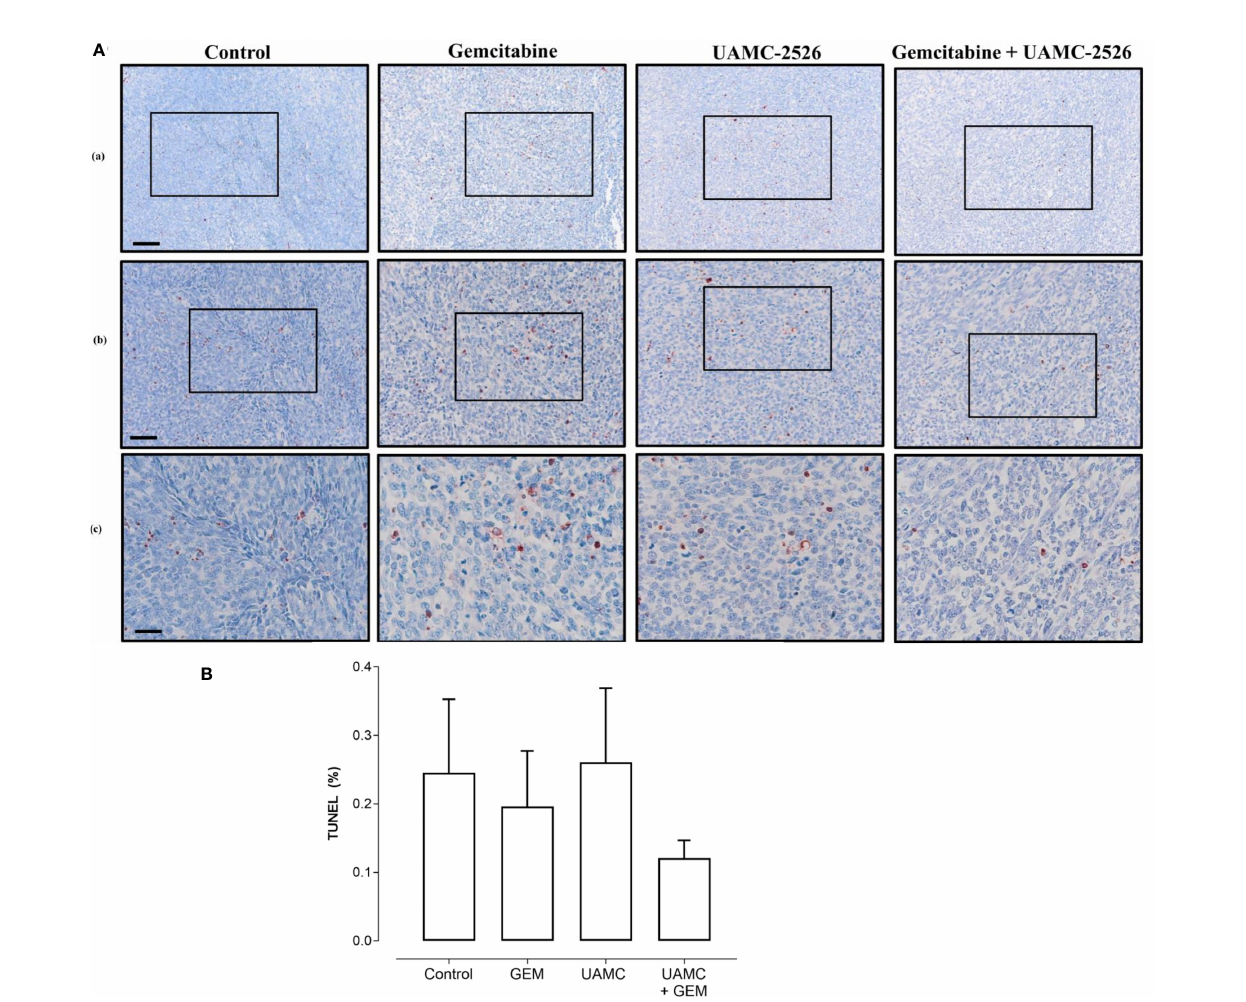
FIGURE 8 | Histological analysis of apoptosis in Panc02 tumors. (A) C57/BL6 mice with Panc02 tumors were treated with vehicle (control), UAMC-2526 (UAMC), gemcitabine (GEM) or a combi-nation of UAMC-2526 and gemcitabine. After treatment, apoptotic cells were detected in tis-sue sections of Panc02 tumors via TUNEL assay. Scale bar = 100 µm (a), 50 µm (b), 20 µm (c). (B) Quanti fi cation of TUNEL. Number of animals in each group was between 8-10. Data were analyzed with factorial analysis of variance (ANOVA), no signi fi cance was found with factors GEM (p=0.321) and UAMC (p=0.750), interaction GEM by UAMC (p=0.631). Scale bar = 100 µm (a), 50 µm (b), 20 µm